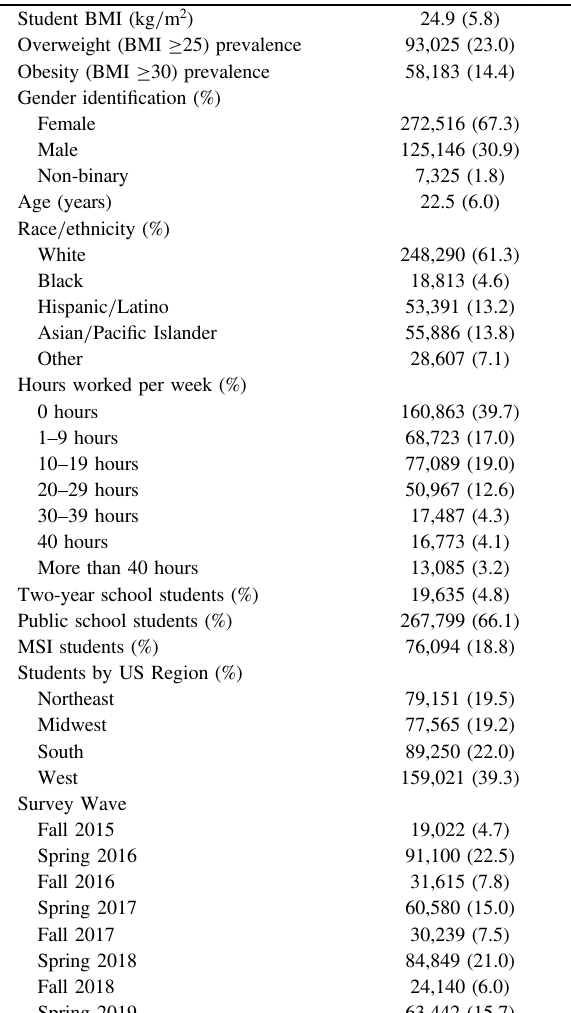
Table 1 Descriptive statistics of the analytic sample. Table 2 Linear mixed model regression results (raw estimates) predicting student